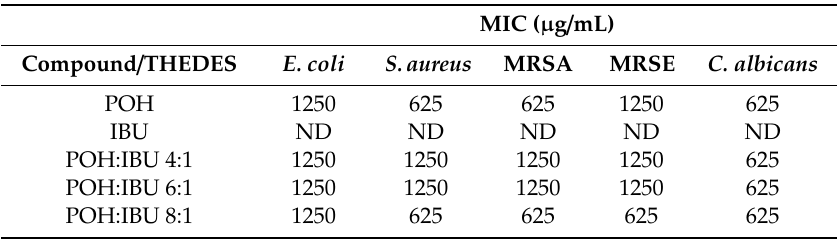
Table 3. MIC values of the individual counterparts and THEDES. Results are presented by formulation for each microbial strain tested. ND—not dissolved.